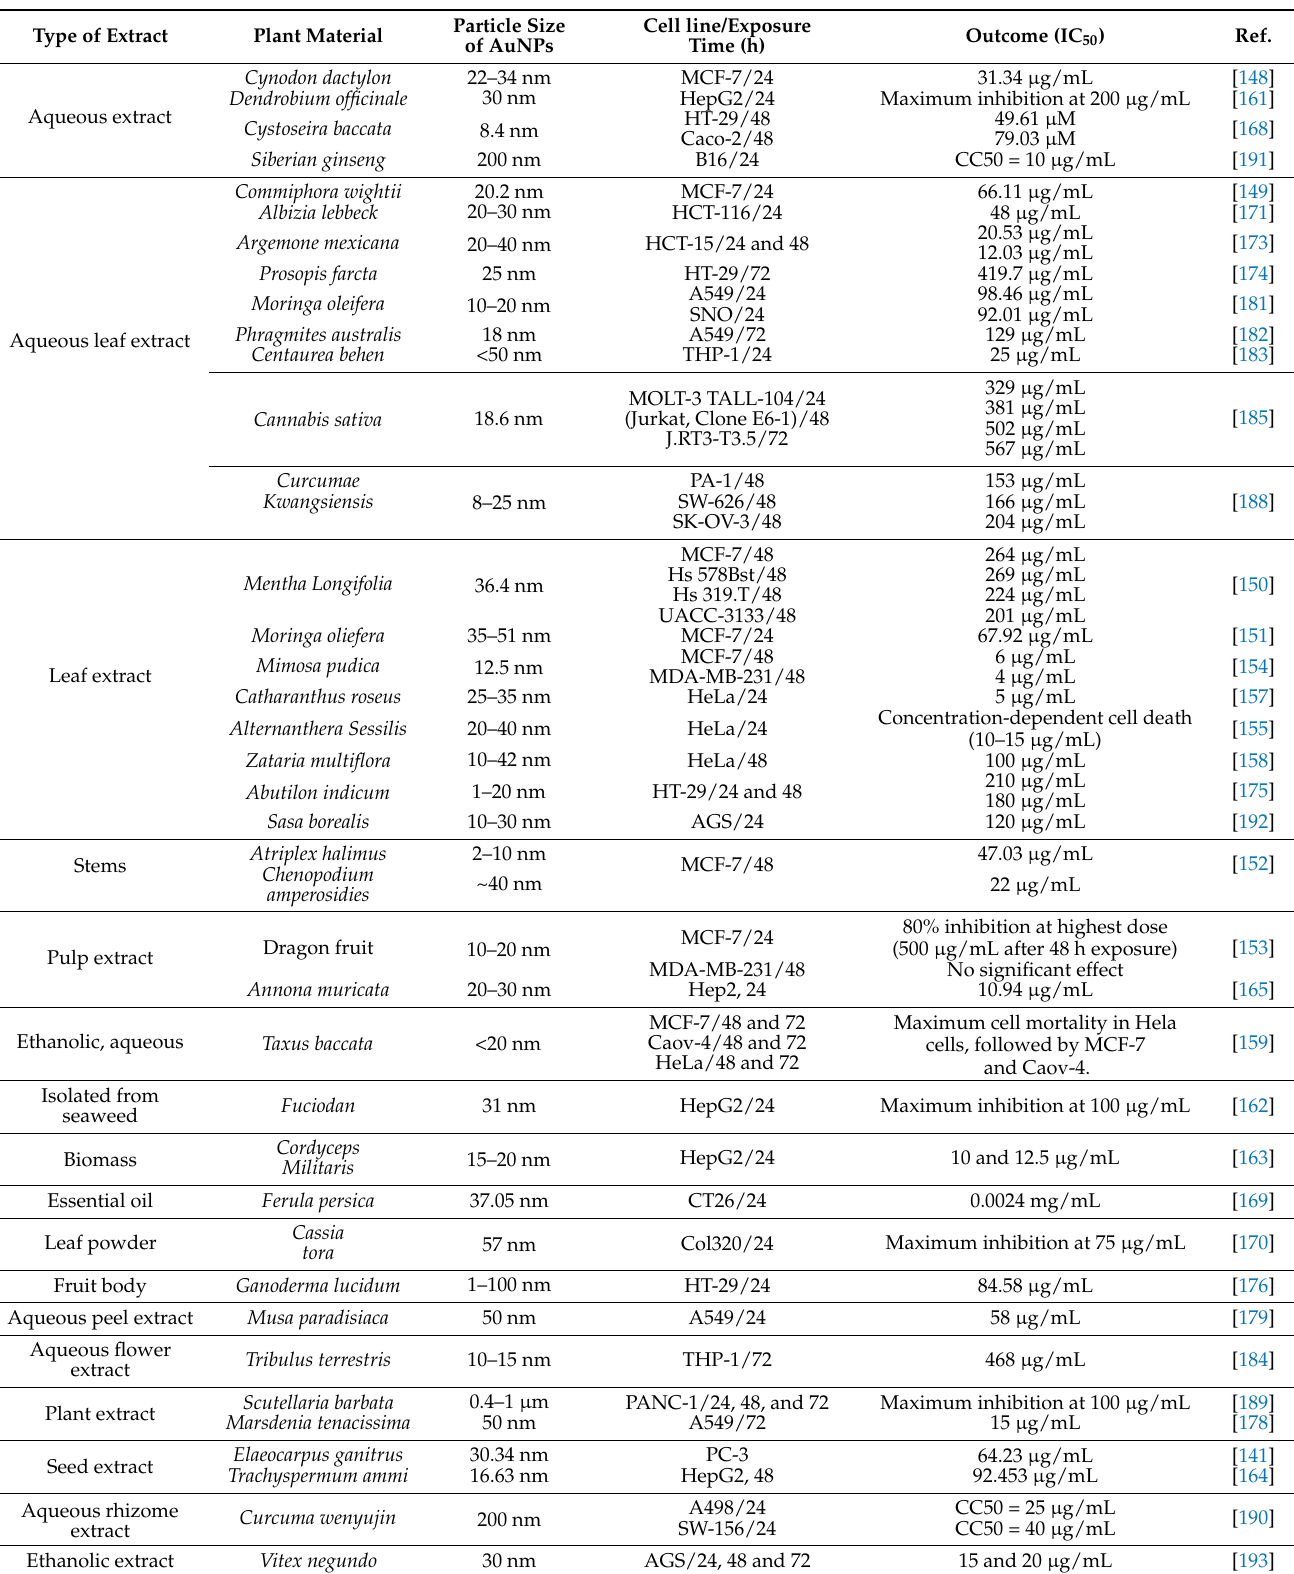
Table 1. Anticancer activity of AuNPs using green material against various